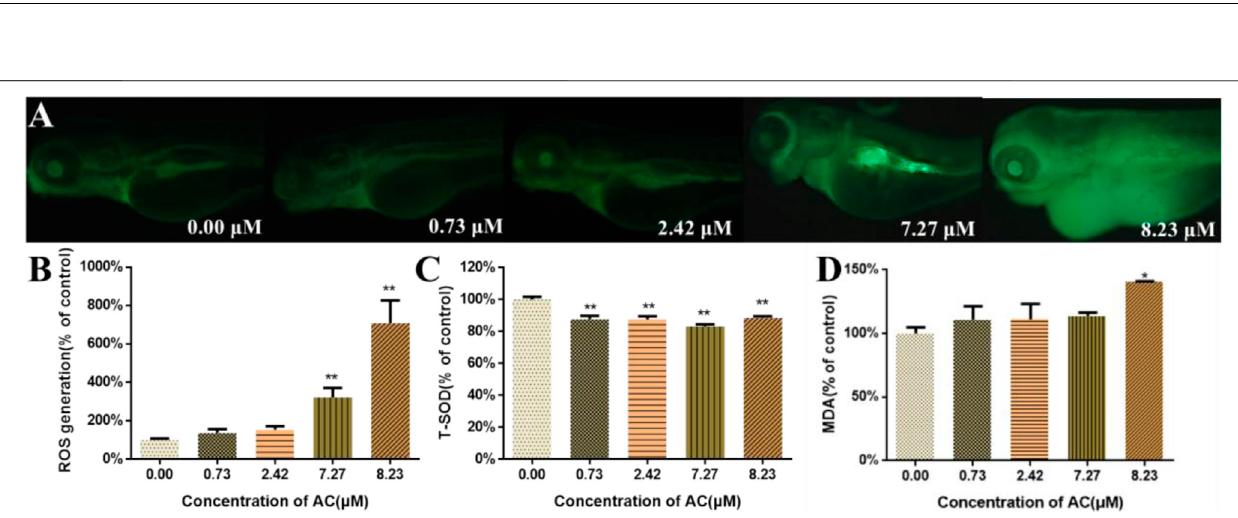
Frontiers in Pharmacology |